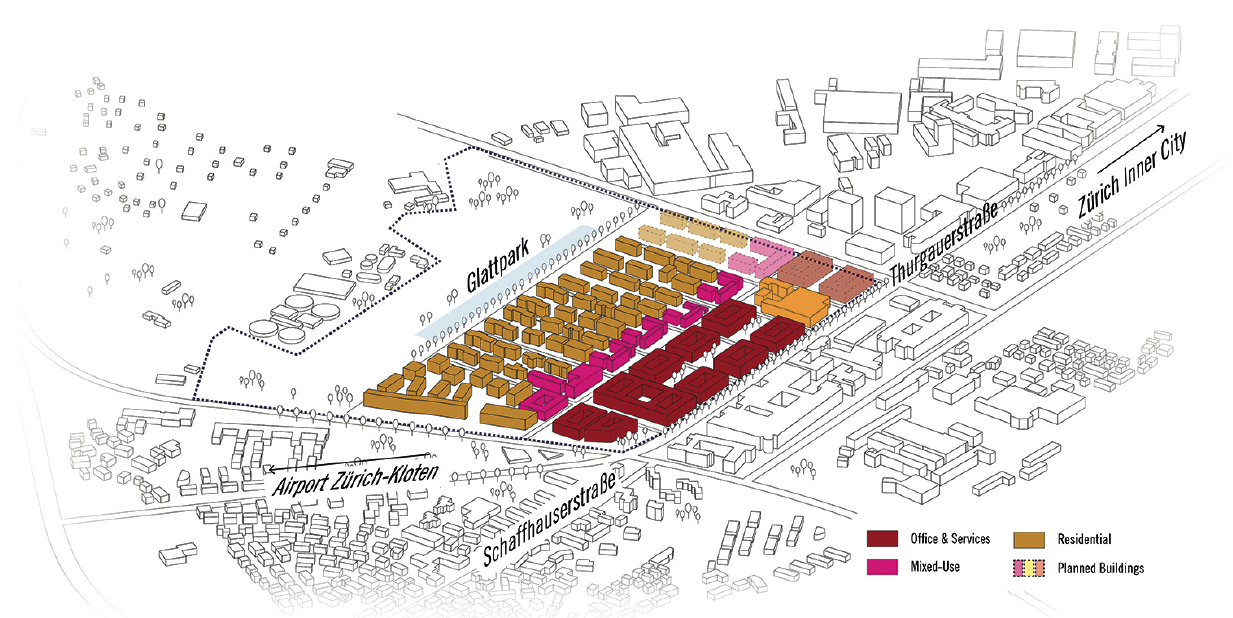
Figure 8. Building structure and distribution of uses for the case study of Glattpark in the city of Opfikon: strong zoning restrictions and high urban densities for office and residential uses. Source: